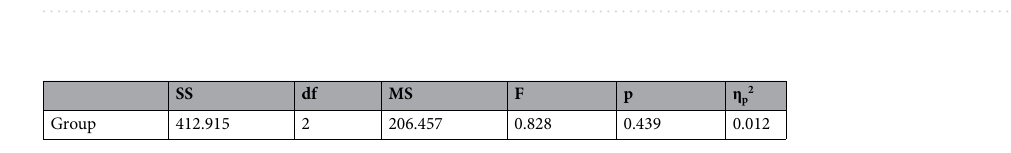
Figure 3. The direction of orientation in hand gestures in different age groups (pre-kindergarteners, school-age children, and adults). Dark and light shadings of bars represent horizontal and vertical arm spread expressions, respectively.